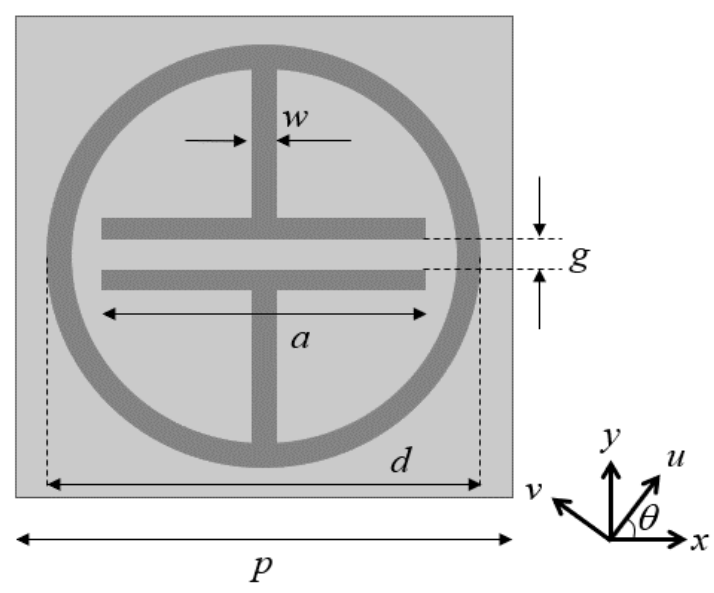
Figure 1. Unit cell of the metasurface (Top view). If the two orthogonally polarized transmission coefficients are equal in magnitude while opposite in phase, the transmitted wave has a characteristic of LHCP with a trans- mitted phase of 2 θ in case of incidence of RHCP wave. The dimensions of the unit cell for operation frequency of 5.8 GHz are set as p = 20 mm, d = 17.26 mm, a = 11.83 mm, g = 1 mm, w = 1 mm. The unit cell for anisotropic surface is made of RT/duroid 5880 with a relative permittivity of 2.2 and a thickness of 3.2 mm. At the frequency of 5.8 GHz, the two orthogonally polarized transmission coefficients are simulated with the same magnitude of − 1.1 dB and opposite phase by ANSYS Electronics desktop software, as shown in Figure